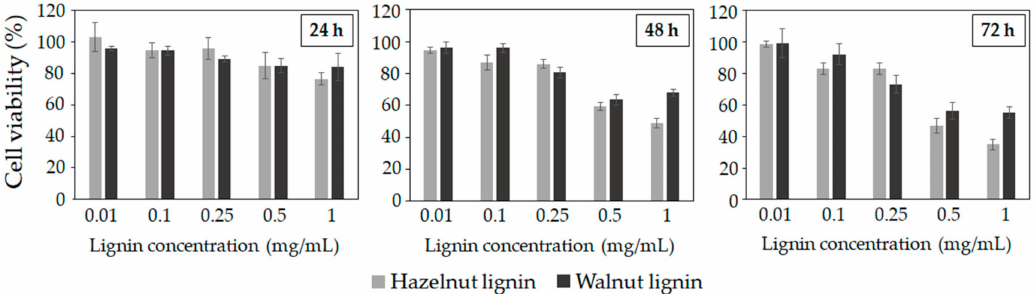
Figure 2. Cell viability (%) of murine fibroblast cell line at di ff erent concentrations of lignin at 24 h, 48 h and 72 h of exposure.